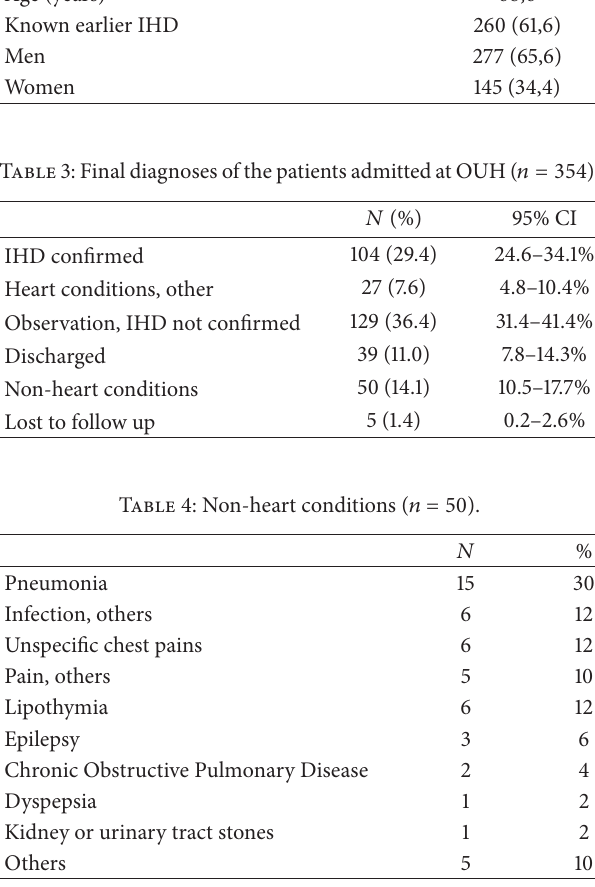
Table 2: Characteristics of the study group ( 𝑛 = 422 ).